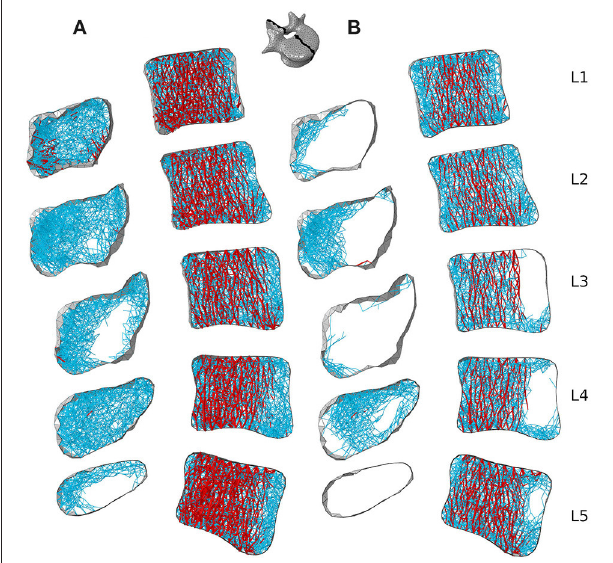
FIGURE 7 | 3 mm mid-sagittal (XY plane) slices for the converged models adapted to the healthy scenario (A) and the sedentary scenario (B) . Cortical shell elements are shown in grey. Thicker truss elements representing the primary structure are shown in red. Trabecular truss elements representing the secondary structure (with a radius of 0.1 mm ) are shown in blue. Truss elements in the dead zone (with a radius of 1 µ m ) are not shown for